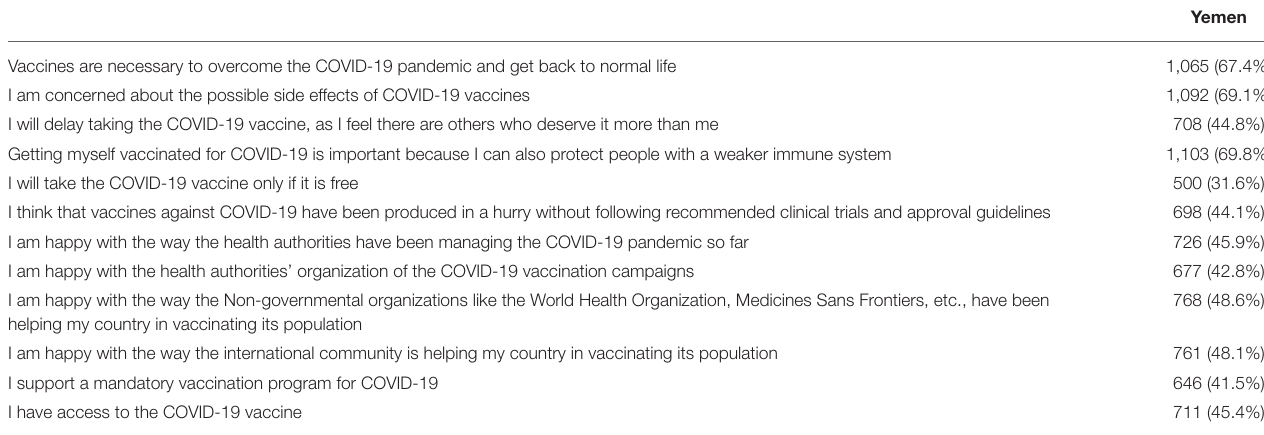
TABLE 3 | Trust in COVID-19 Vaccines and Health Authorities, and access to vaccines.